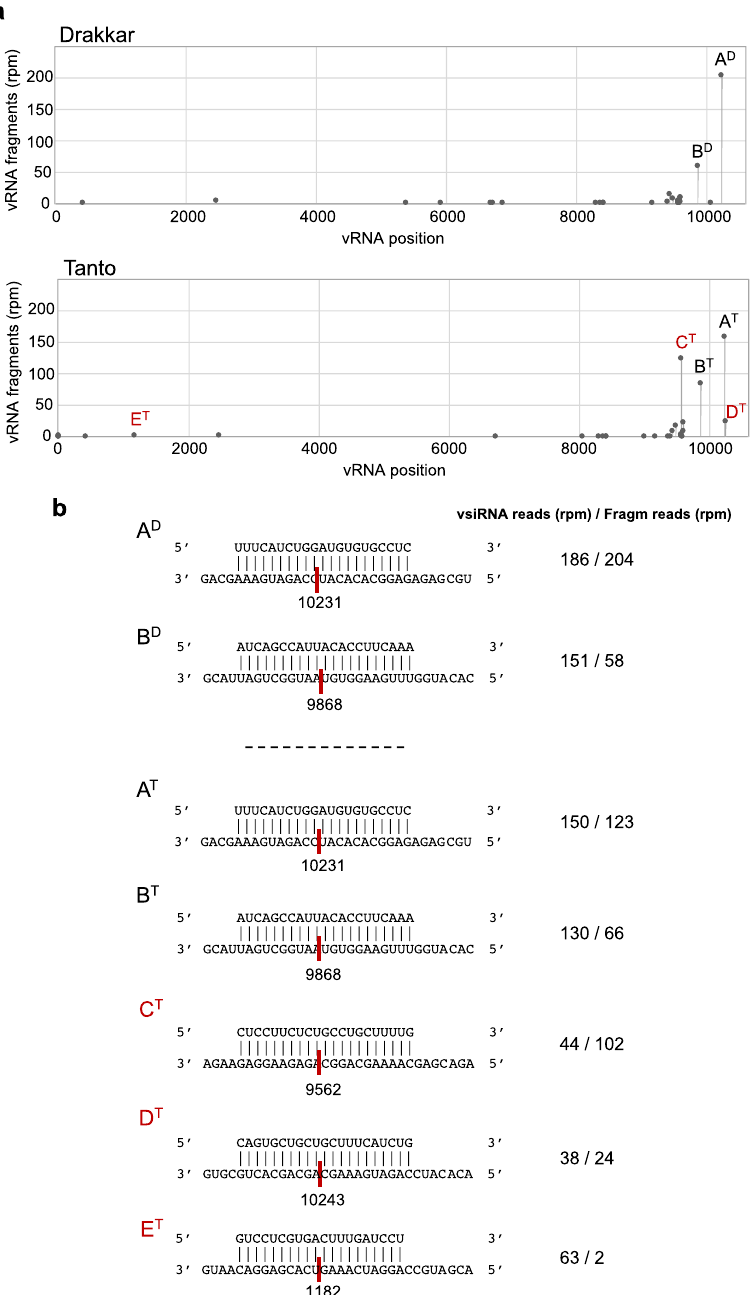
Fig. 5 vsiRNA-guided cleavage of viral RNA. a Target plots showing 5 ′ -signature abundance along the viral RNA identi fi ed through degradome sequencing of local infection sites in Drakkar and Tanto leaves (Top). A to E letters in the target plots denote cleaved positions represented by highly abundant signatures that occurred either in both cultivars (A D /A T ; B D /B T ), with higher frequency in Tanto (C T ) or even exclusively only in Tanto but not in Drakkar (D T and E T ). b Base-pair alignments between viral RNA and vsiRNA at A to E positions are shown together with normalized abundance (r.p.m.) for the speci fi c vsiRNA and the normalized abundance (r.p.m.) of the corresponding viral RNA cleavage fragment in the degradome